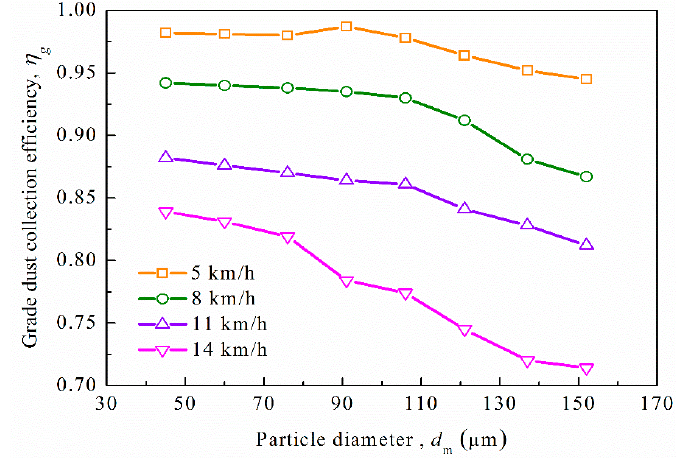
Figure 14. Influence of traveling speed on the grade dust-collection efficiency.